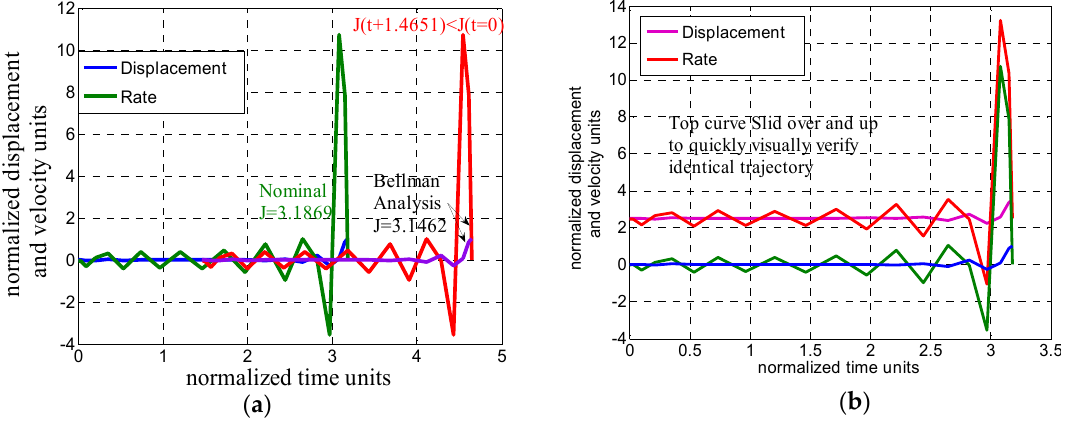
Figure 6. Bellman analysis for chosen time t = 1.4651: cost = 3.1462 < 3.1869. ( a ) Normalized FSS extremal tip displacement and rate trajectories for the nominal (zero) start point and also for Bellman’s analysis (slid to the right for the different start point) are simultaneous. ( b ) scaled (for depiction) graphically “sliding” the Bellman curves up and over to heuristic verification of Bellman’s principle.